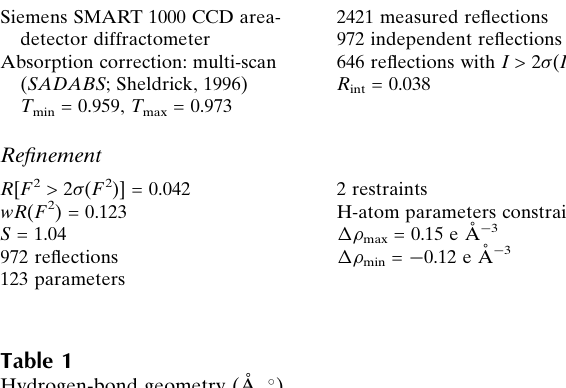
Hydrogen-bond geometry (A˚ , (cid:1)